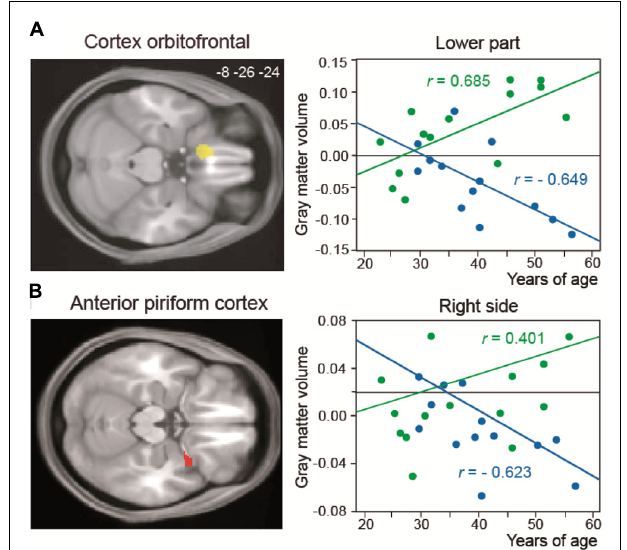
FIGURE 5 | Structural reorganization in perfumers. Relationship between structural modifications and years of age.The regression lines between the gray-matter volume and years of age (from 20 to 60 years old) show a positive slope in older experts (OE, green) and a negative slope in older controls (OC, blue) for (A) the left GR/MOG and (B) the right anterior piriform cortex. GR/MOG, gyrus rectus/medial orbital gyrus (modified from Delon-Martin etal.,